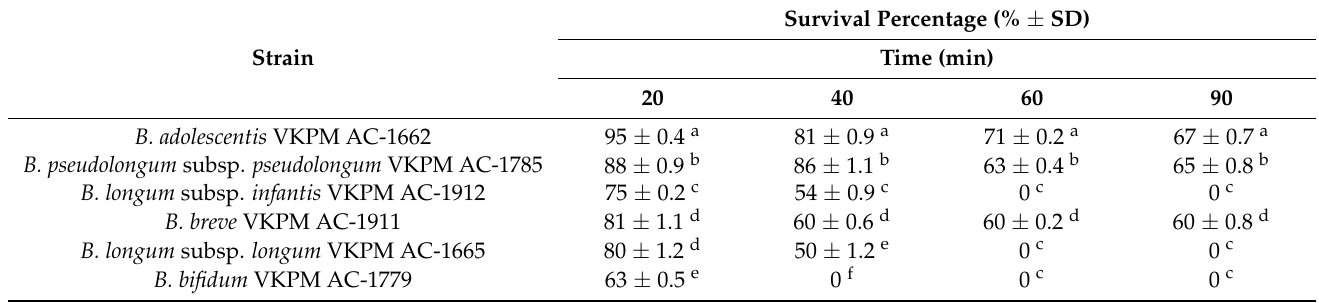
Table 2. Tolerance of Bifidobacterium strains to simulated gastric juices (pH 2.0).